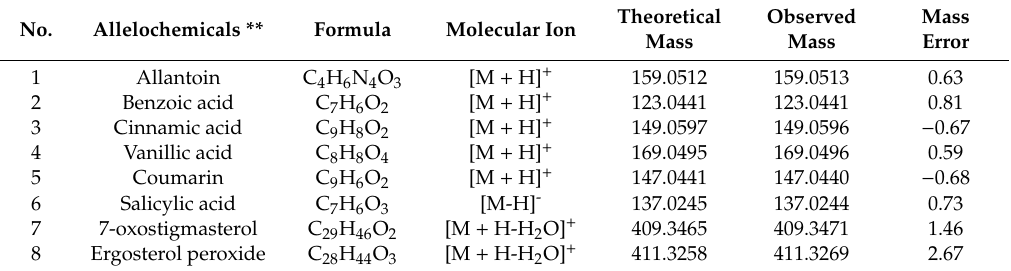
Table 4. Molecular information of 8 predominant allelochemicals detected in 9 OM rice cultivars by